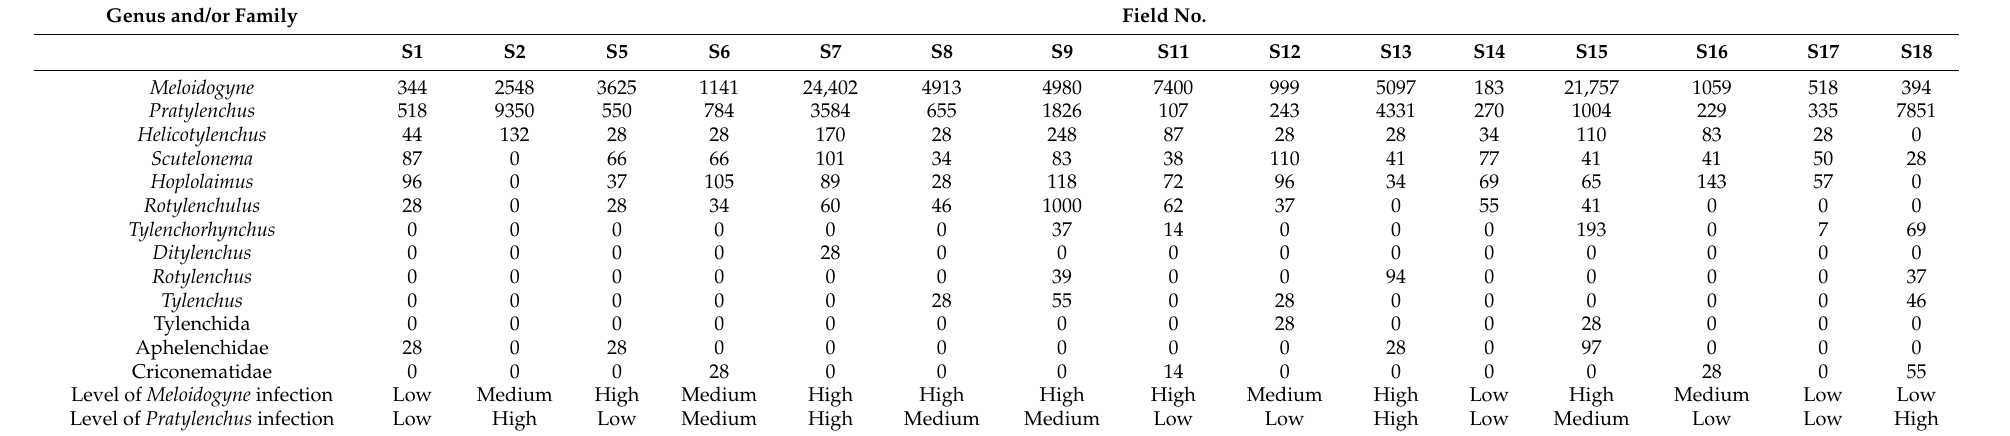
Table 1. The community structure and abundance of plant parasitic nematodes in 20 g soybean root samples collected during the 2018/19 growing season from 15 fields of commercial producers in the Highveld region of the Mpumalanga province of South Africa. Genus and/or Family